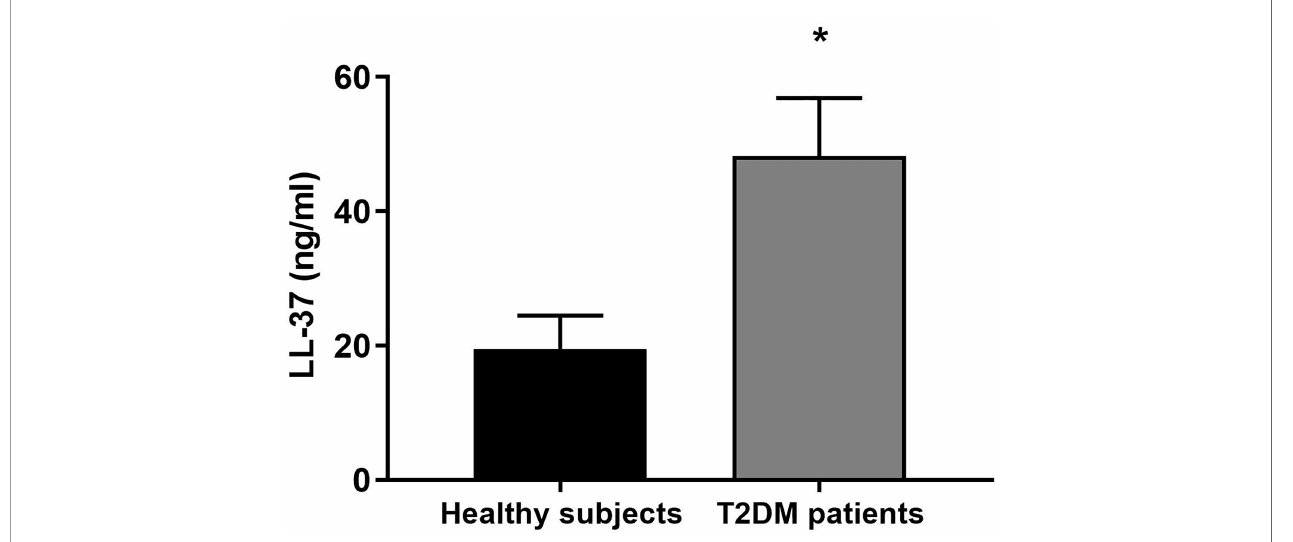
FIGURE 1 | LL-37 serum levels in healthy subjects and patients with T2DM. Serum concentrations of LL-37 were assessed in healthy subjects and patients with T2DM. Data were analyzed by unpaired t-test (two-tailed). Data are expressed as mean ± SEM; healthy subjects (n = 10), T2DM patients (n = 12). *P < 0.05 vs. healthy